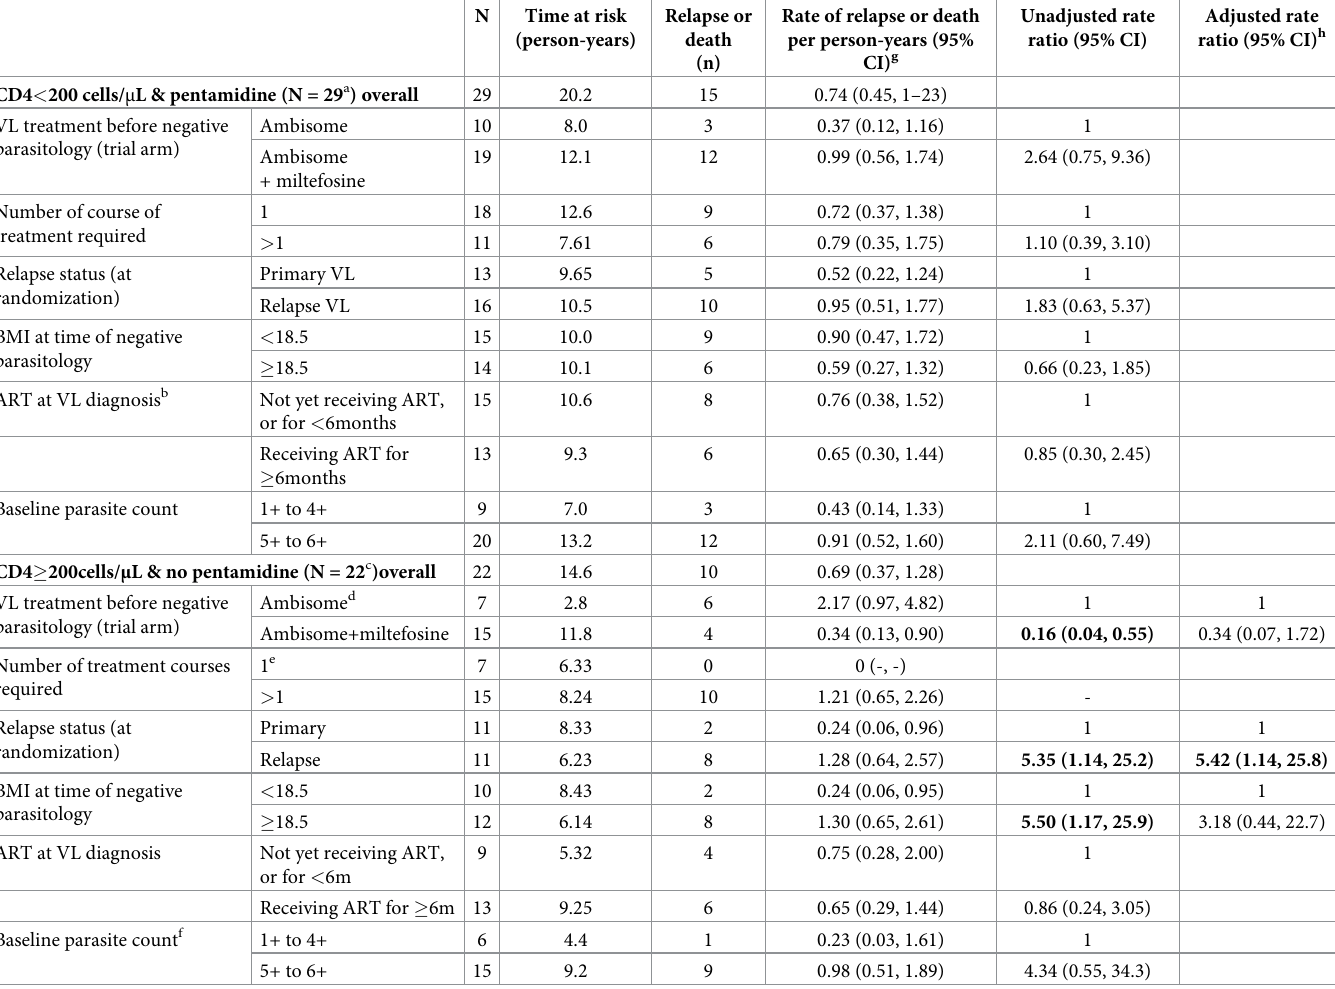
Table 4. Associations with relapse or death by strata of CD4 count and pentamidine